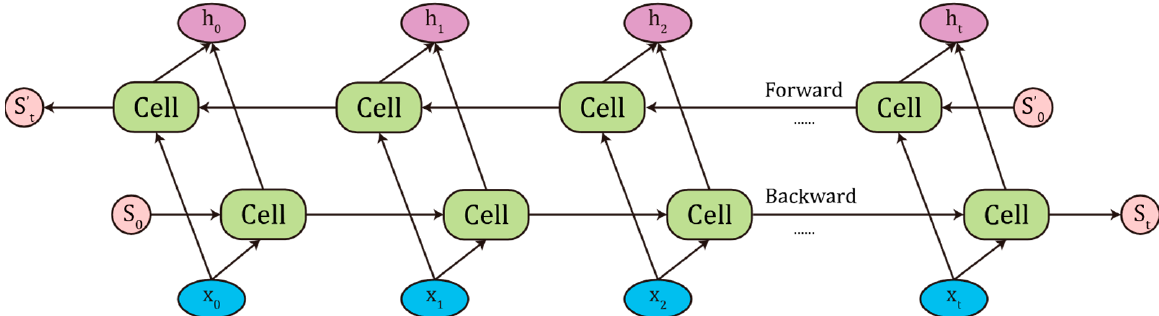
Figure 5. Unrolled bidirectional recursive neural network chain-loop structure.